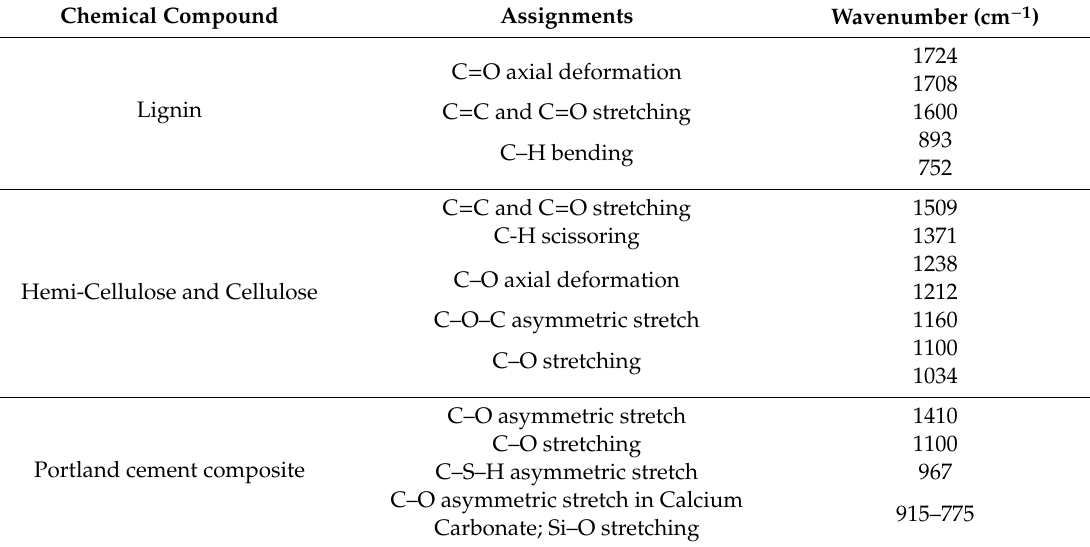
Table 1. Assignments of the FTIR bands of the samples